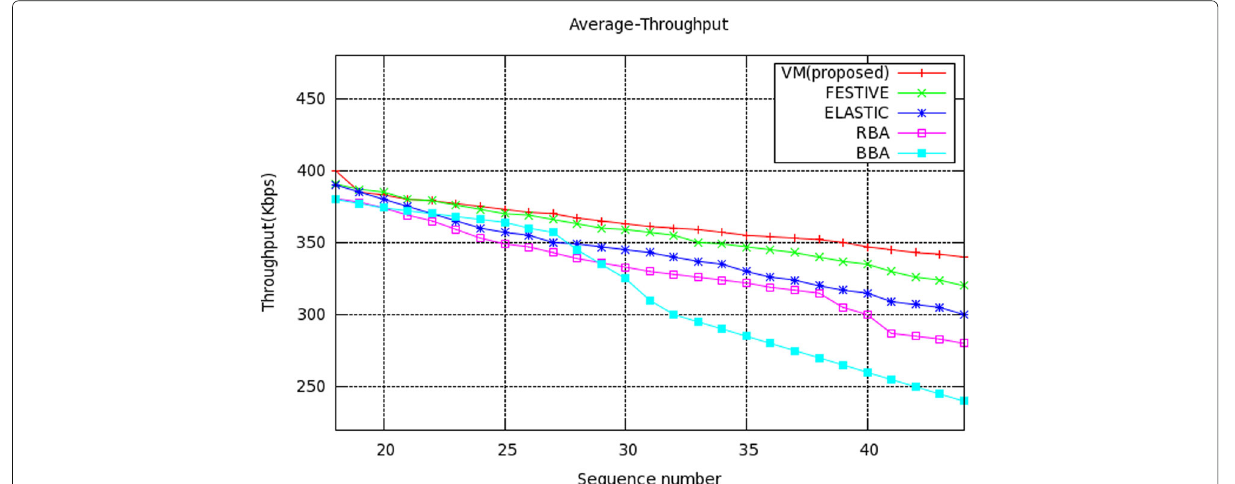
Fig. 5 Average throughput of buffer management